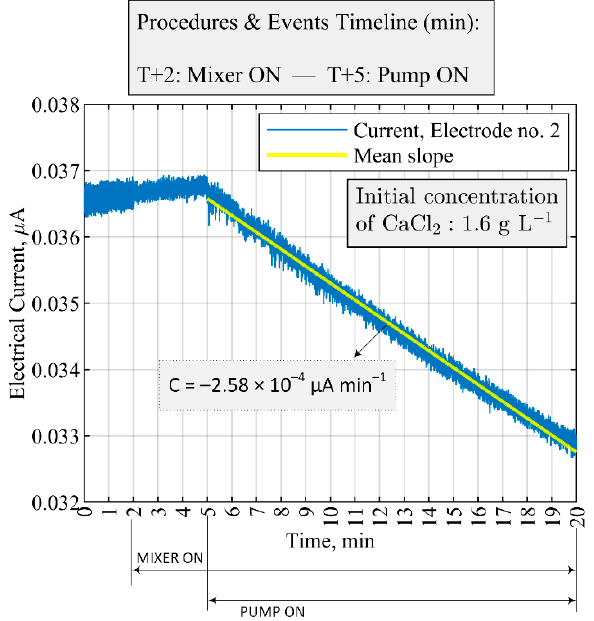
Figure 12. Fault detection and malfunction scenario by a single sensor of the ERT system correspond- ing to case no. 3 in Table 3. A normal operation for the mixer (100 RPM) and pump (40 mL min − 1 ) but the feed solution that flows into the crystallizer contains 0 g L − 1 CO 2 −